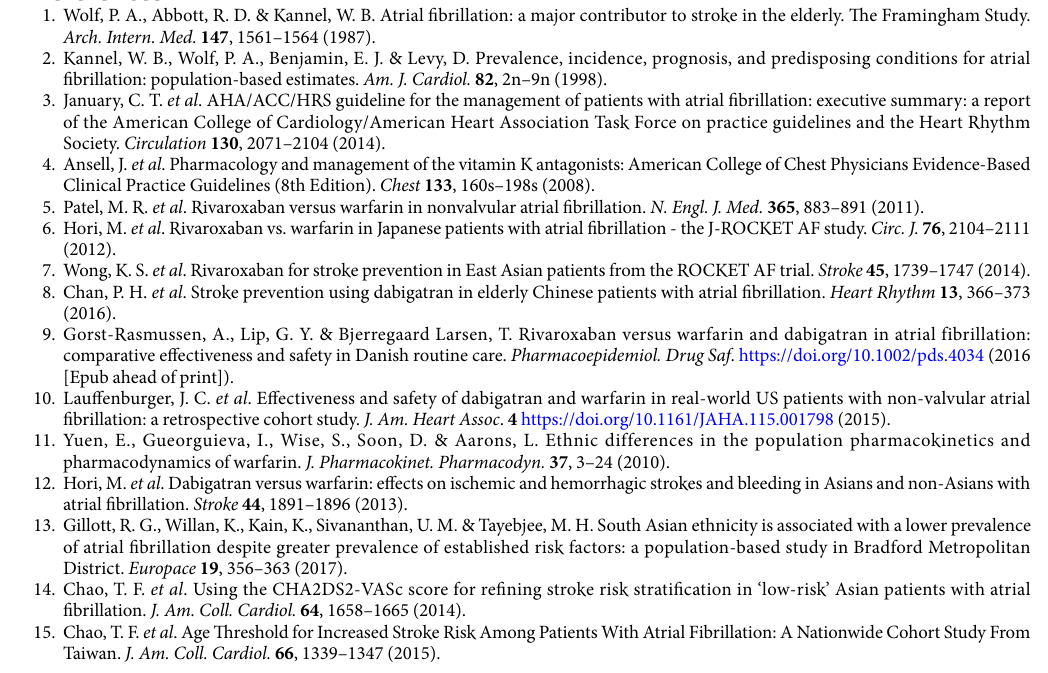
medications for more than 30 days were censored from this study. With an uncertain status of adherence, our data still showed improved effectiveness and an improved safety profile with rivaroxaban. Finally, only baseline demographics within 12 months before the index date were included for propensity score matching. Medical conditions that occurred more than one year prior to the index date were not taken into consideration, which may have resulted in an underestimation of the baseline risk for thrombosis and bleeding. Nevertheless, previous stud- ies have applied the 12 month period to validate the CHA 2 DS 2 -VASc scoring system 32 , and the same approach has also been used in several observational studies investigating the effectiveness and safety of NOACs 10,23,33 . Comorbidities, such as heart failure, hypertension, and diabetes mellitus, were considered as chronic diseases and would be detected by claims data as long as patients re-visited their physician and refilled medications. Since patients with chronic conditions generally need long-term management, it is most likely that these patients will continuously use health services and thus be recorded in the claims database. Therefore, we should be able to identify the pre-existing conditions correctly even if the conditions were first diagnosed outside the one-year per-index period. In conclusion, rivaroxaban was associated with a lower risk of VTE and ICH than warfarin in patients with non-valvular AF. At doses over 15 mg, rivaroxaban was associated with a significantly lower risk of ischemic stroke. Our study supports rivaroxaban as an effective and safe choice even among the elderly population.